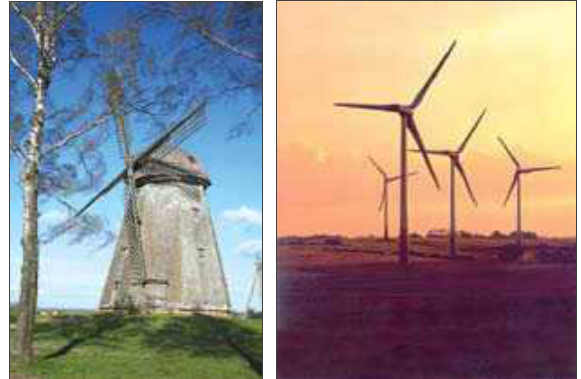
Fig. 1. Mills in the landscape: old mill in Lazdininkai and windpowerstation farm in kretinga